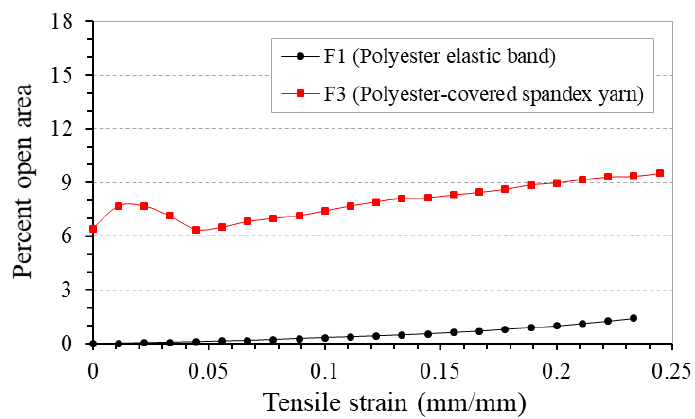
Figure 14. Percent open area-tensile strain curves of fabrics F1 and F3 made with different types of weft yarn.